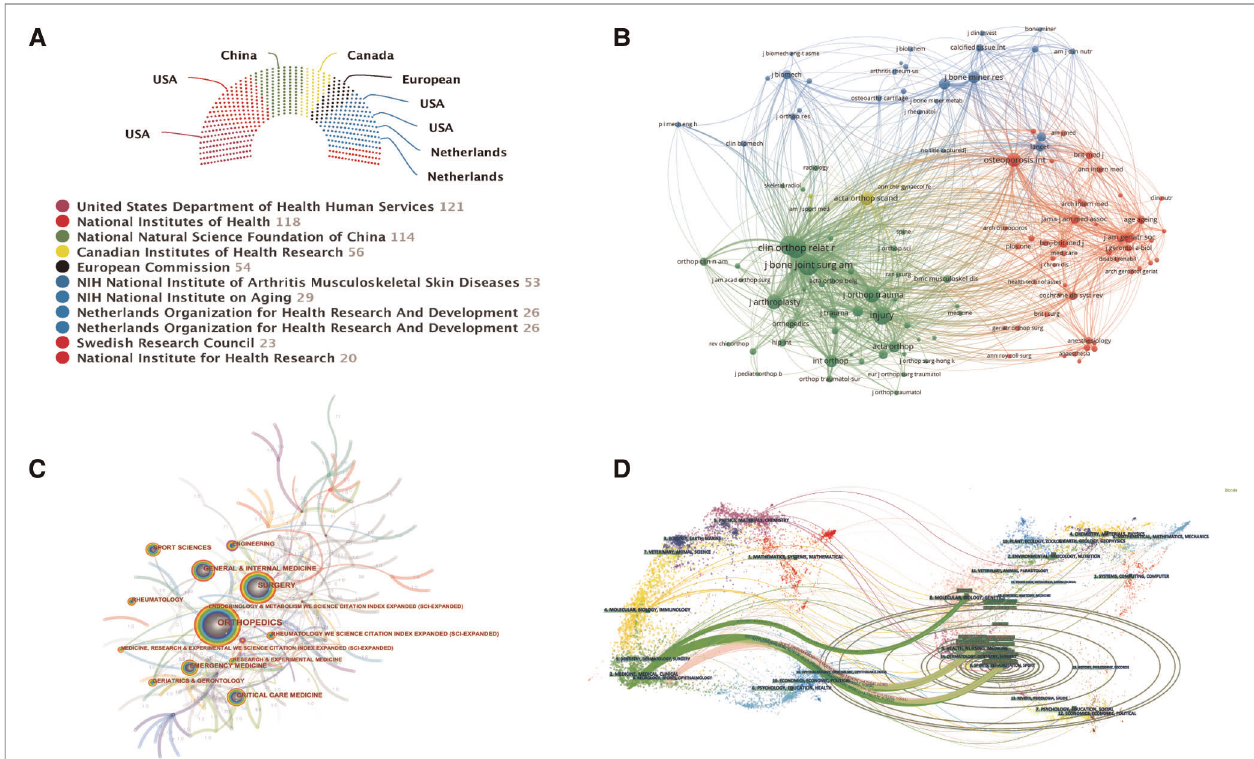
FIGURE 5 | ( A ) Top 10 related funding agencies for the support of FNF research. ( B ) Journal co-citation analysis by using VOSviewer. Each node represents a different journal, and the node size is proportional to the number of citations. ( C ) Co-occurring network map of subject categories on FNF research by using CiteSpace. ( D ) The dual-map overlay of the journals on FNF research by using CiteSpace.